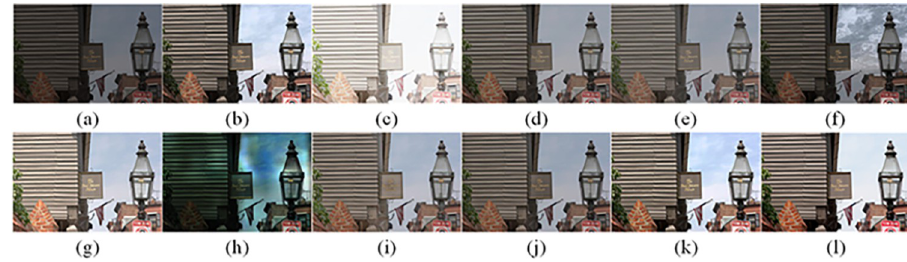
Fig 28. Comparisons of the ten algorithms in enhancing low-light image 18. (a) low-light image (b) AGCWD (c) Al-Ameen (d) BHE2PL (e) BIMEF (f) BPDHE (g) LIME (h) MSRCR (i) NPEA (j) SRIE (k) OURS (l) Normal light